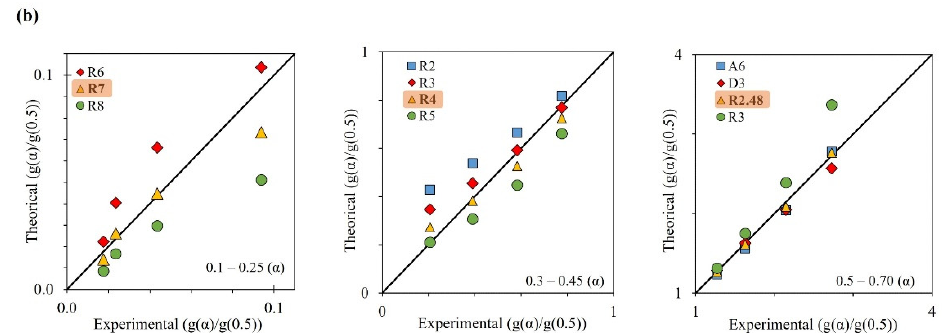
Figure 5. ( a ) Reaction models using generalized master plot method (g( α )/g(0.5) vs. α ), and ( b ) ex- perimental and theoretical curves (g( α )/g(0.5)).